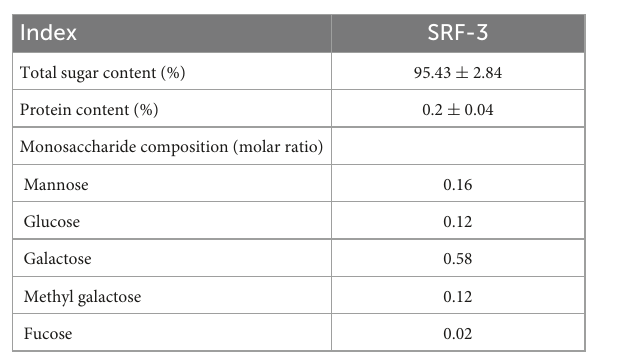
TABLE 1 Component characterization of SRF-3.